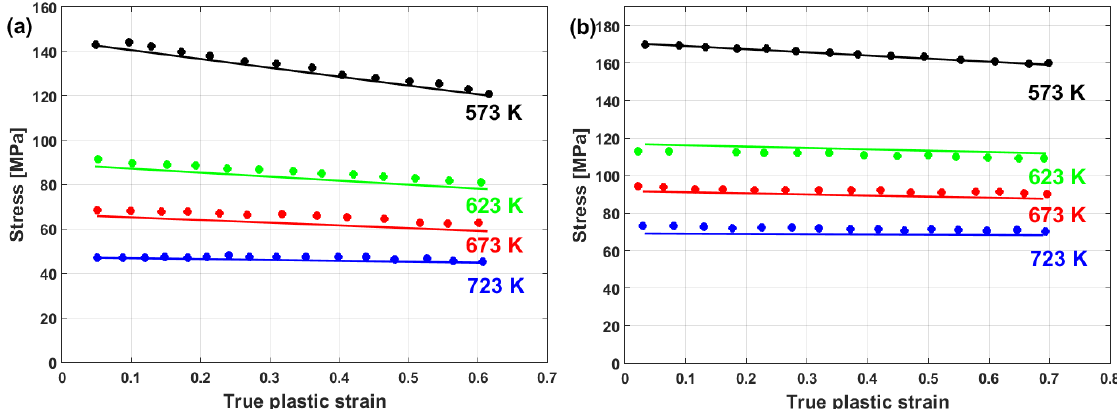
Figure 23. Comparison of experimental stresses (markers) and predicted stresses (solid lines) using the modified JC model that was introduced by Lin et al. [78] for Zn-Mg-Cu alloy at ( a ) 0.005 s −1 and ( b ) 0.1 s −1